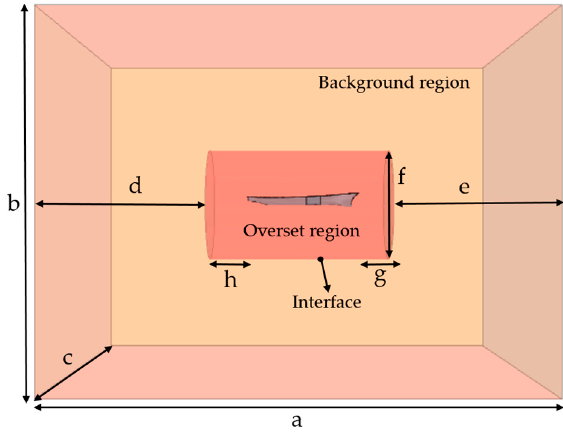
Figure 7. Region representations and domain dimensions.